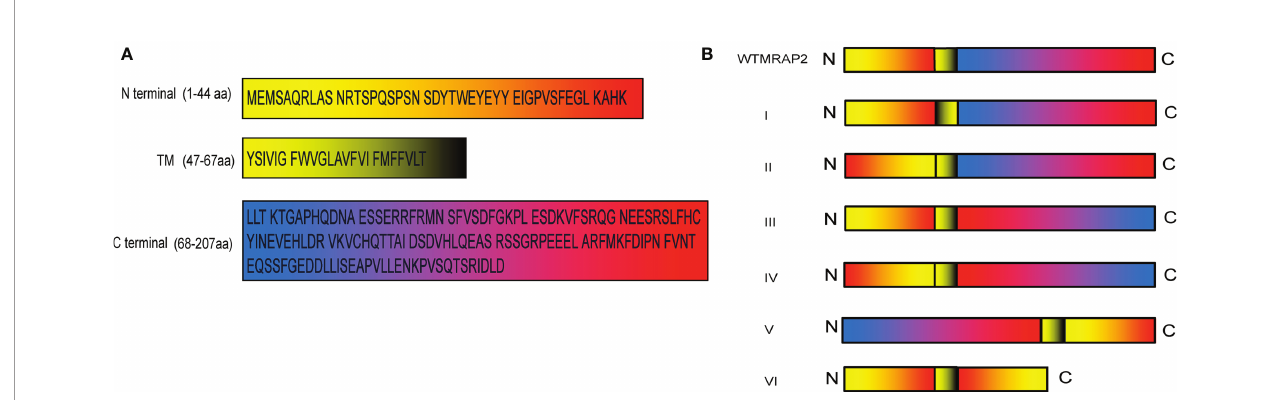
FIGURE 1 | (A) Sequences of mouse melanocortin receptor accessory protein 2 (mMRAP2). The different colors of the sequences in the black box indicate the N-terminal, transmembrane (TM), and C-terminal domains. (B) Schematic representation of the six MRAP2 variants. From top to bottom : wild-type MRAP2 (wtMRAP2), I (TM inversion), II (N-terminal inversion), III (C-terminal inversion), IV (N- and C-terminal inversion), V (N- and C-terminal transposition), and VI (replacement of C-terminal by the inverted